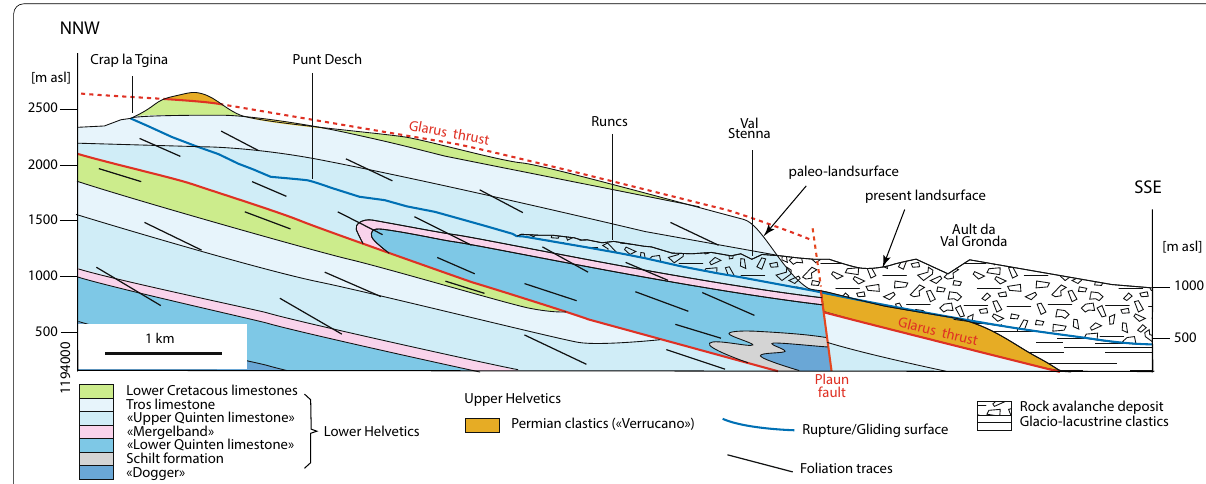
Fig. 19 Cross-section along the western transect of Fig. 7A showing the rupture and gliding surface with the geologic structure of the source area of the rock avalanche as well as of the bedrock substrate. Note steep slope just north of the Plaun